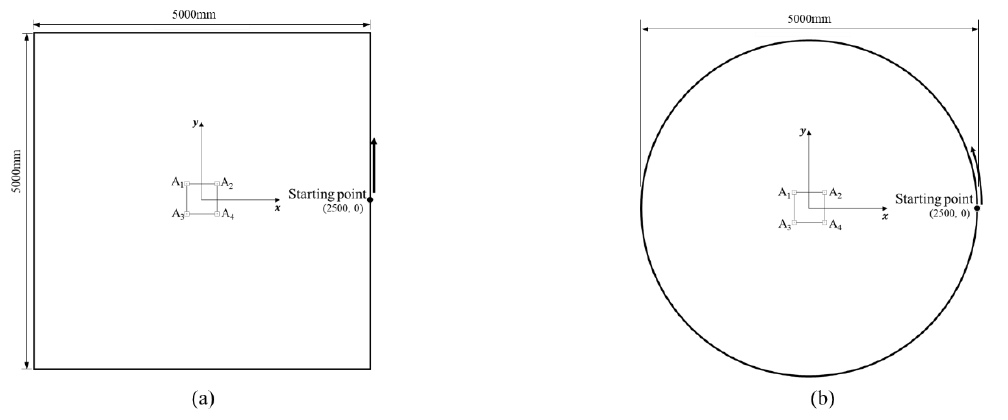
Figure 7. Two reference paths used in the simulation: ( a ) square path with a side length of 5 m, ( b ) circular path with a diameter of 5 m.